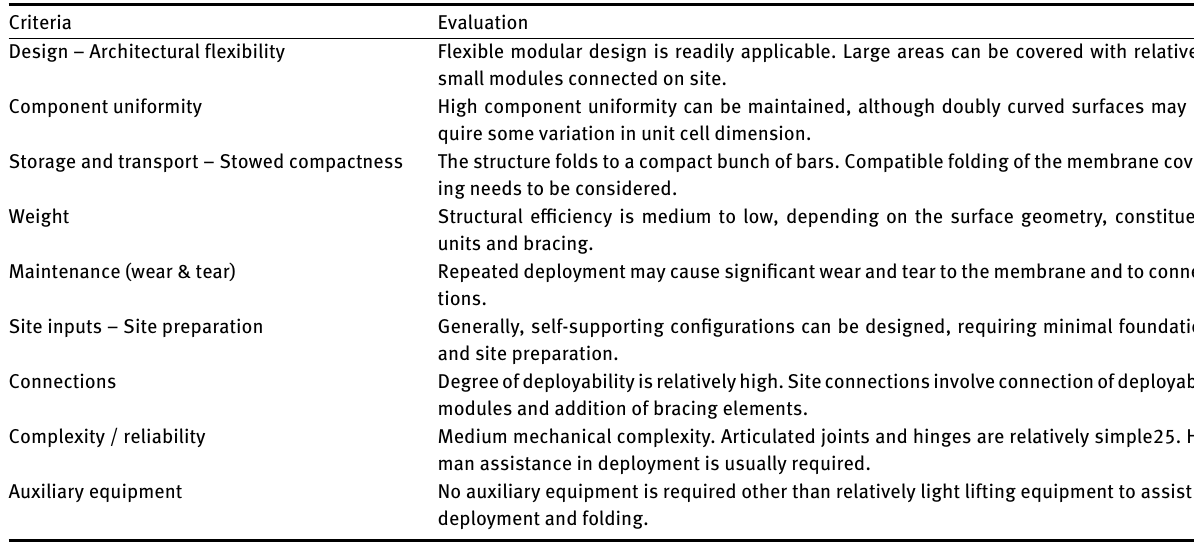
Table 1: Evaluation of the double layer pantographic grids by Hanaor and Levy Criteria